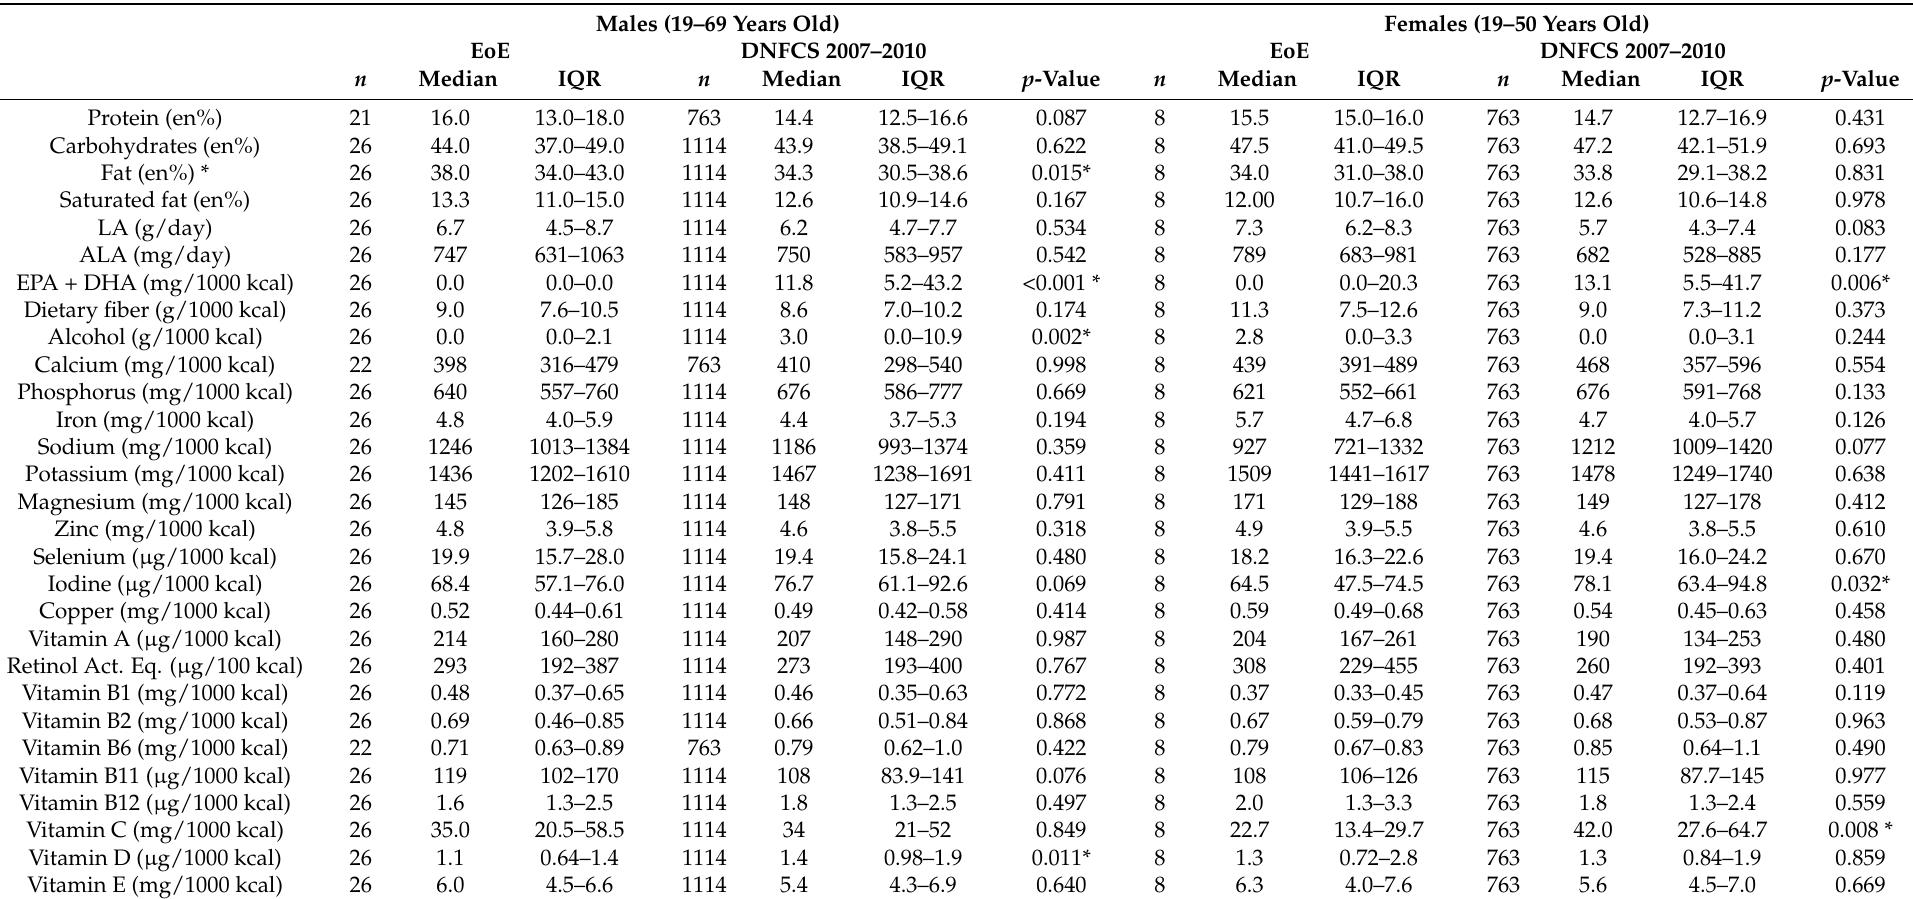
Table 4. Comparison of nutrient intakes between EoE patients and the general Dutch population for males 19–69 years and females 19–50 years, corrected for energy intake. For protein, calcium and vitamin B6 comparisons are only presented for males and females 19–50 years old. Nutrient intakes are shown per 1000